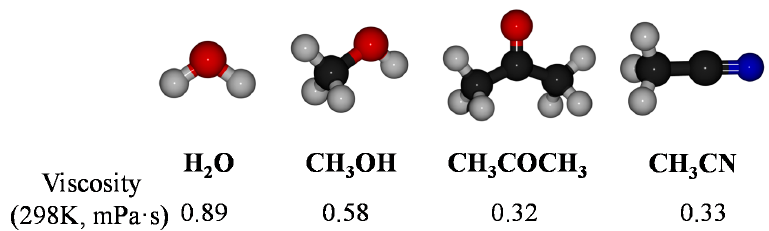
Figure 7. Molecular structures and viscosities of water, methanol, acetone, and acetonitrile at 298 K. In order to study the kinetics of the hydrolysis of NaBH 4 catalyzed by Co–B particles, the catalyst dosage on the HG was examined. Figure 8 shows plots of the HG of the process versus time for different dosage of the Co–B catalysts. It is clear from the figure that the HG rate increases with increasing amount of the Co–B catalyst used.